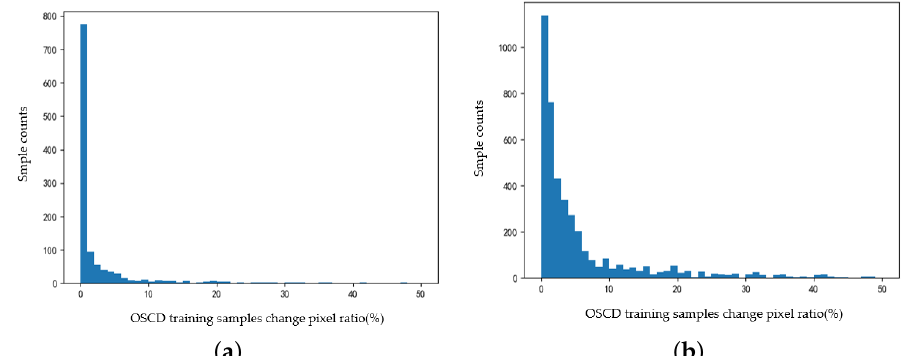
Figure 10. Distribution of change pixels in ACD. ( a ) Before sample equalization. ( b ) After sam- ple